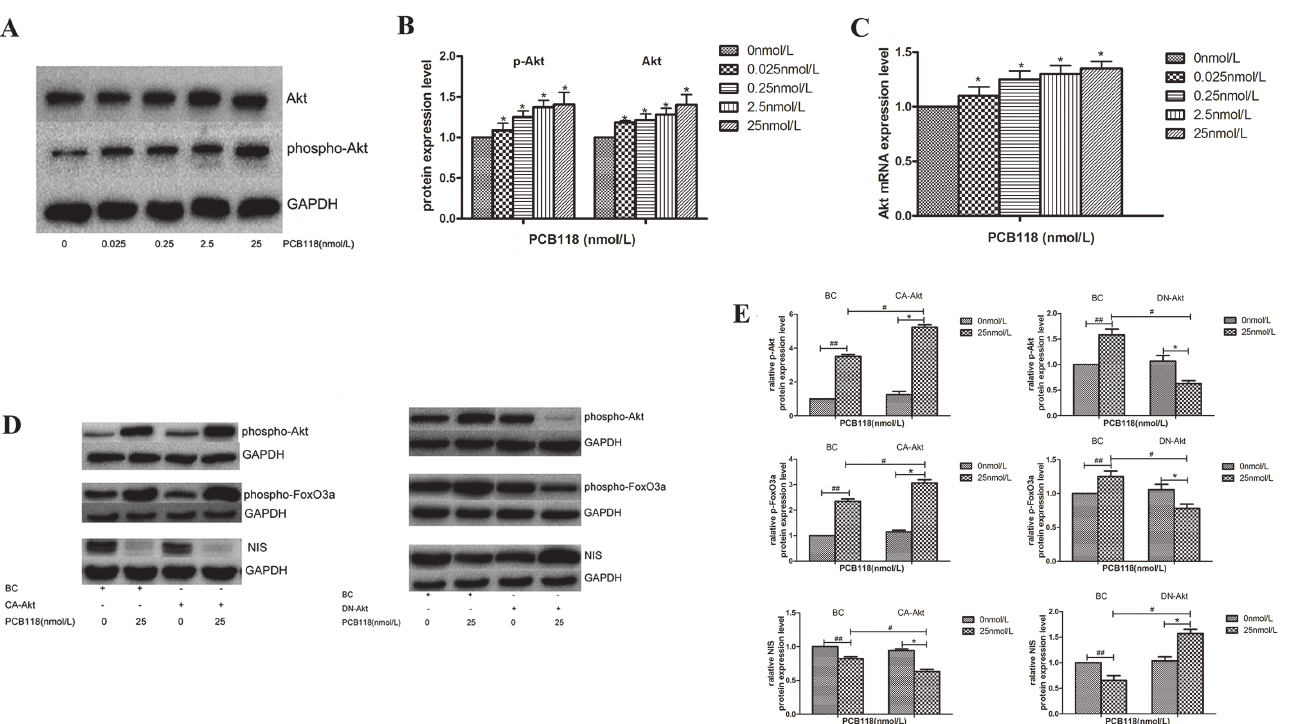
Fig 6. Akt pathway was activated in PCB118-treated FRTL-5 cells. Cells were treated with DMSO or various concentrations of PCB118 (0.025 – 25 nM) for 24 or 48 h. Whole cell lysates were analyzed by western blotting using antibodies recognizing Akt and p-Akt (A and B). Total RNA was isolated for qRT-PCR of Akt (C). Up-regulation of Akt expression was induced by CA-Akt and down-regulation was induced by DN-Akt in FRTL-5 cells. After treatment with 25 nM PCB118 for 48 h, whole cell lysates were analyzed by western blotting using antibodies recognizing p-Akt, p-FoxO3a, and NIS (D and E). Results show sections of blots from one experiment of the three that yielded similar results (A and D) or represent the mean ± SD of three independent experiments (B, C, and E). GAPDH served as the loading control in western blotting. * p < 0.05, compared with the DMSO control group (Fig. 6B, C) * p < 0.05, compared with the DMSO control group transfected with the CA-Akt or DN-Akt plasmid (Fig. 6E); # p < 0.05, compared with the 25 nM PCB118-treated group transfected with the BC plasmid; ## p < 0.05, compared with the DMSO control group transfected with the BC plasmid. The relative ratio of target mRNA/ β -actin and target protein/GAPDH in solvent control group was set as